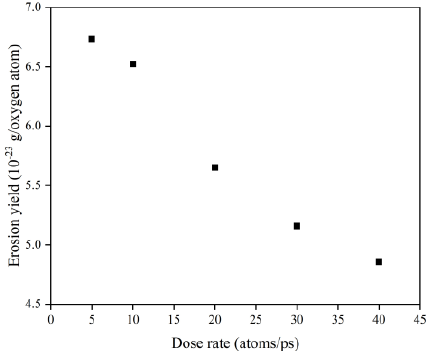
Figure 30. Erosion yield of the Kapton under atomic oxygen impact at different dose rates.